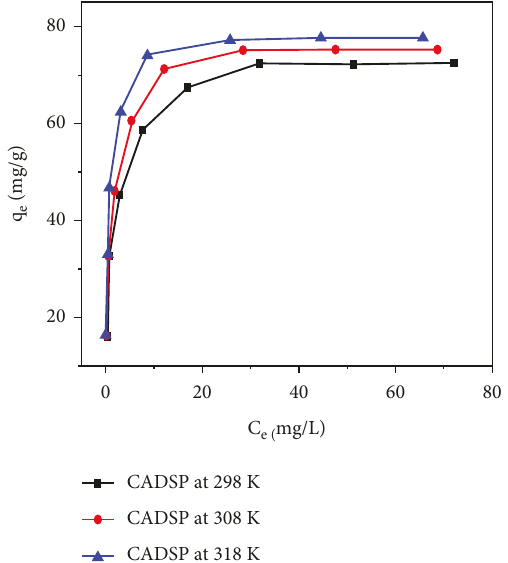
Figure 8: Biosorption isotherm for Cr (VI) onto CADSP at dif- ferent temperatures (298-318